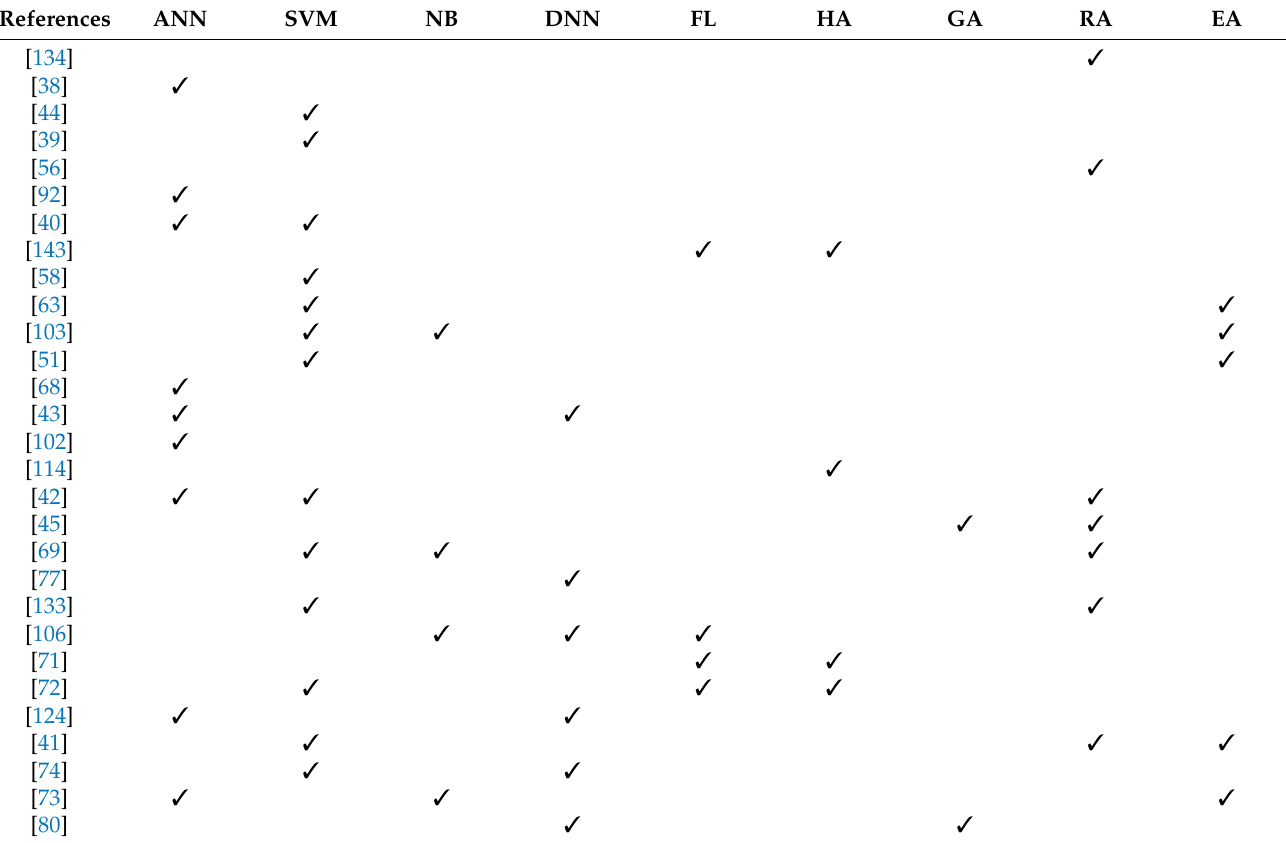
Table 3. Comparison of the different techniques applied in the studies. Artificial Neural Networks (ANN), Support Vector Machine (SVM, Naïve Bayes (NB), Fuzzy Logic (FL), Hybrid Algorithms (HA), Genetic Algorithms (GA), Regression Algorithms (RA), Ensemble Algorithms